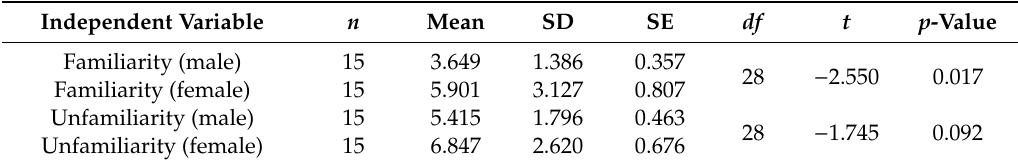
Table 12. Independent t -test results for gender di ff erences in the product search times.